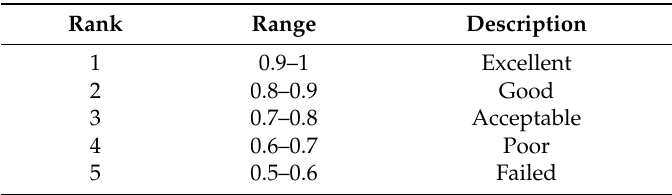
Table 5. The accuracy ratings of AUC